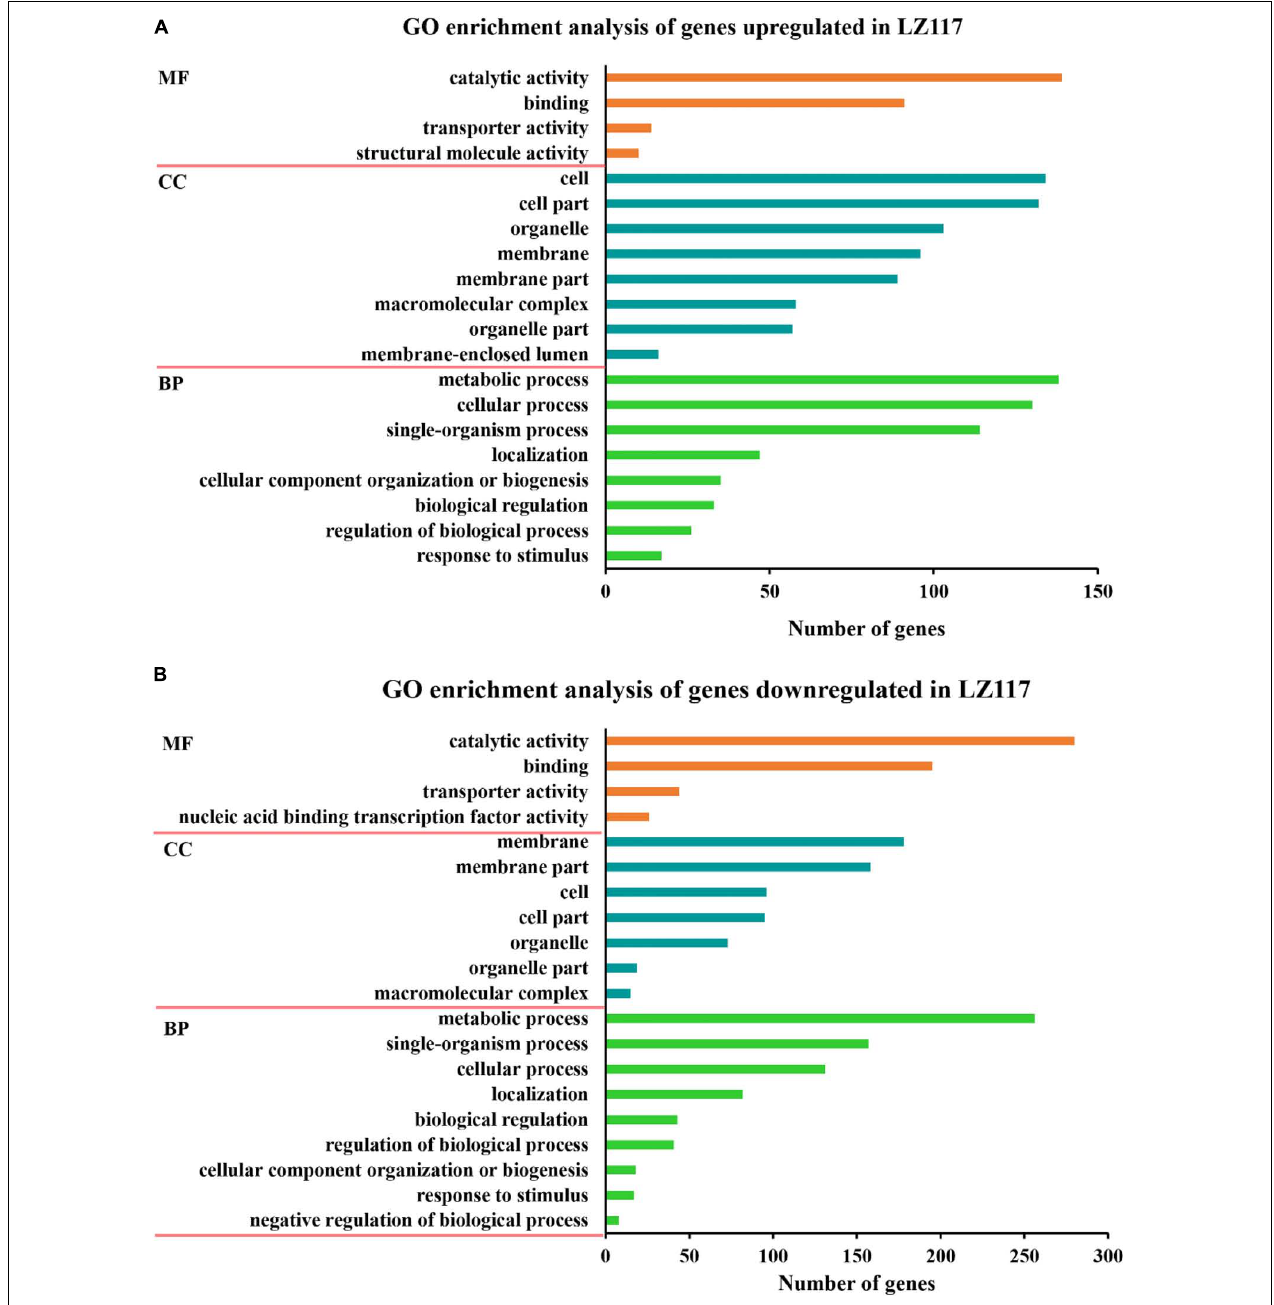
FIGURE 3 | GO enrichment analysis of the changed genes. Results of GO enrichment analysis of the upregulated (A) and downregulated (B) genes in T. harzianum LZ117 relative to T. harzianum K223452 were presented. The Y axis represents the name of the most enriched GOs: (MF) molecular function, (BP) biological process, while the X axis represents the number of DEGs in each enriched